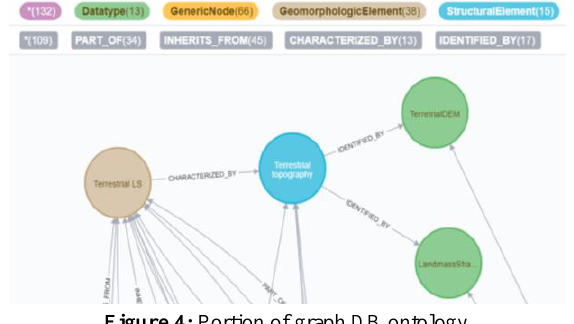
Figure 4: Portion of graph DB ontology